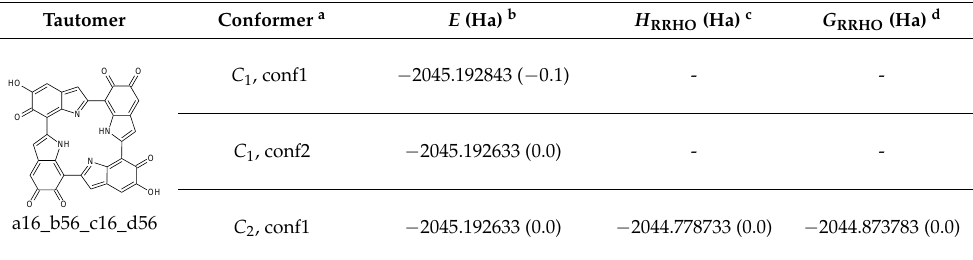
Table 15. KP-8e, neutral form in vacuo.